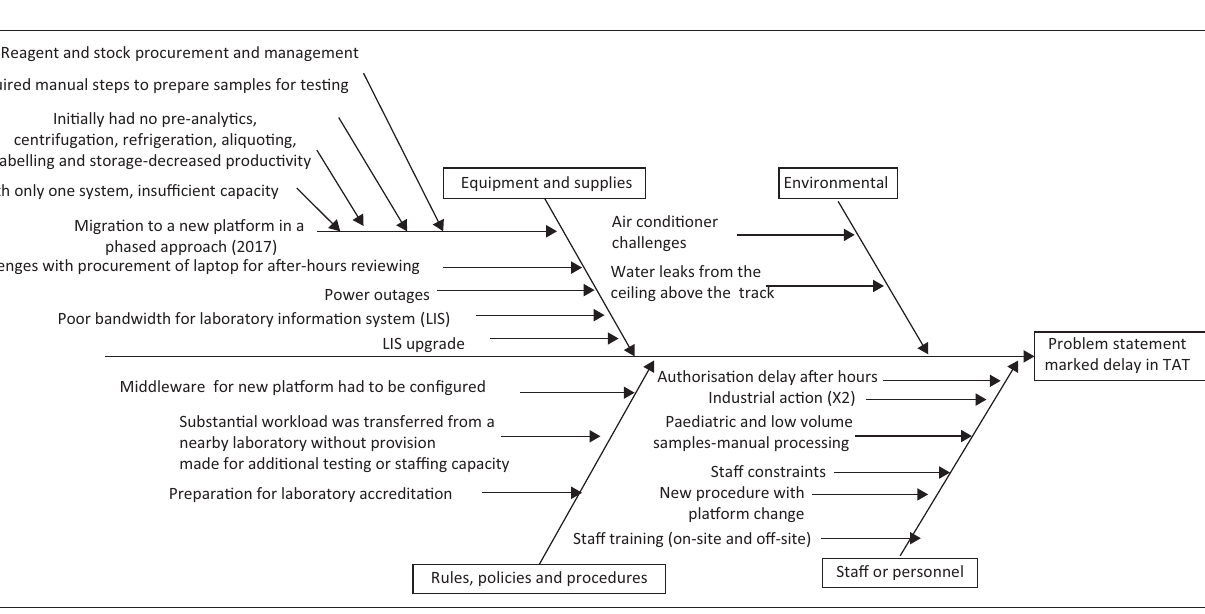
FIGURE 3: Root cause analysis diagram developed in conjunction with the laboratory manager at a high-volume laboratory, Gauteng, South Africa,